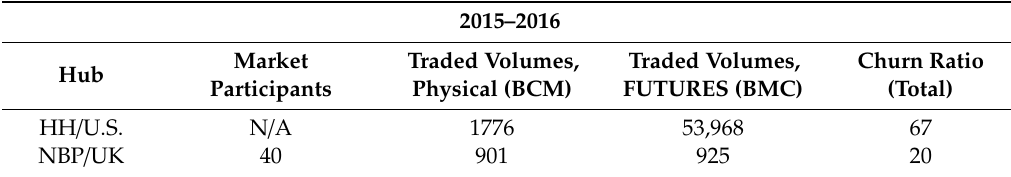
Table 1. The United States and UK traded volumes and churn. Source: OFGEM [14] and Cornerstone Research, IEA [15].